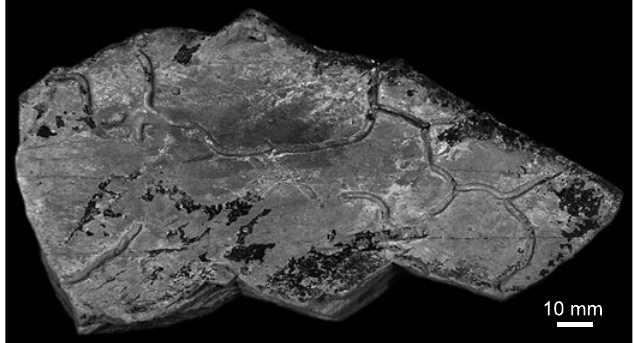
Fig. 8. Regular to irregular network graphoglyptid Megagrapton irregu­ lare Książkiewicz, 1968, MZM Ge 32947, from Velká nad Veličkou, Czech Republic,